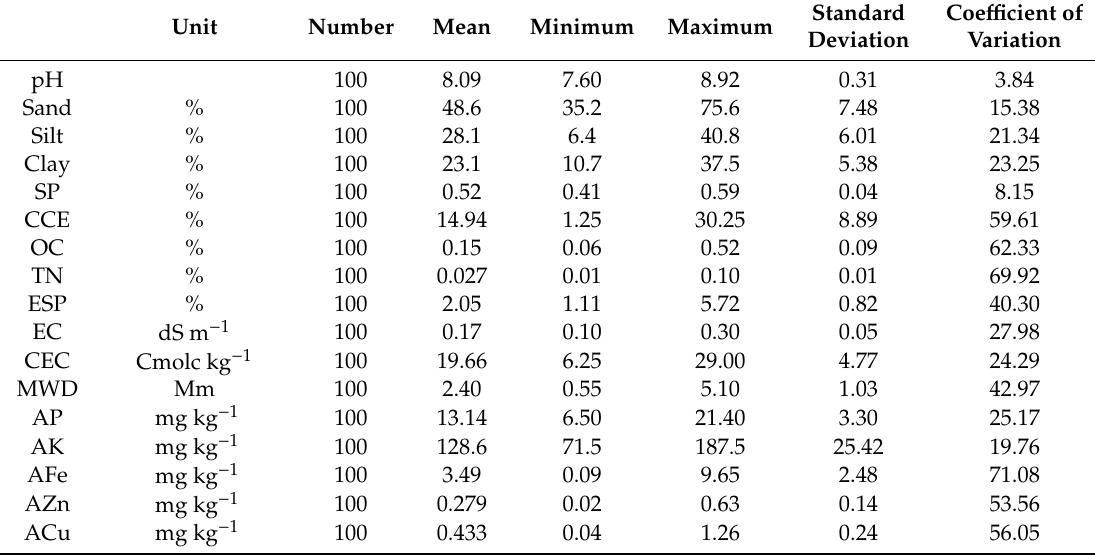
Table 2. Descriptive statistics for soil properties and rainfed wheat